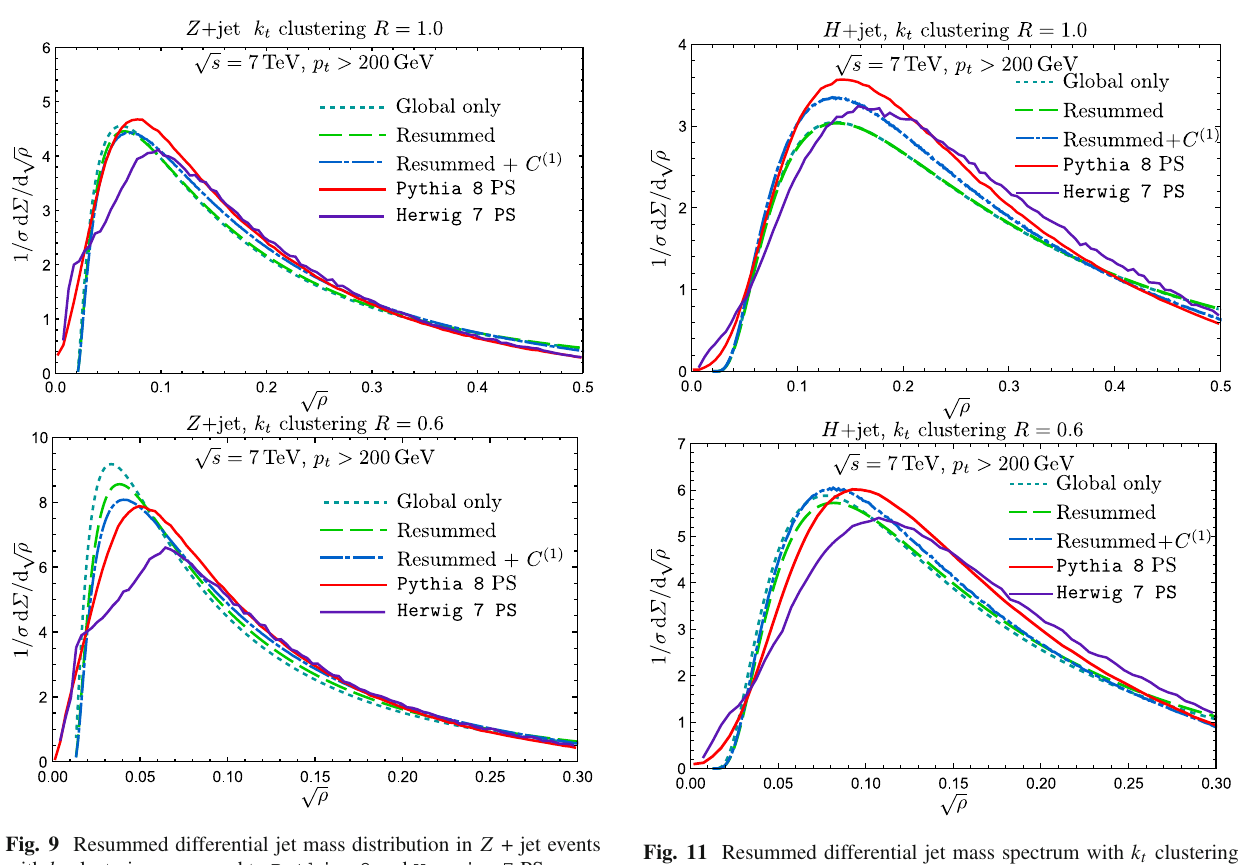
Fig. 11 Resummed differential jet mass spectrum with k t clustering compared to Pythia 8 and Herwig 7 parton showers for R = 1 . 0 and R = 0 . 6 in the process gg →